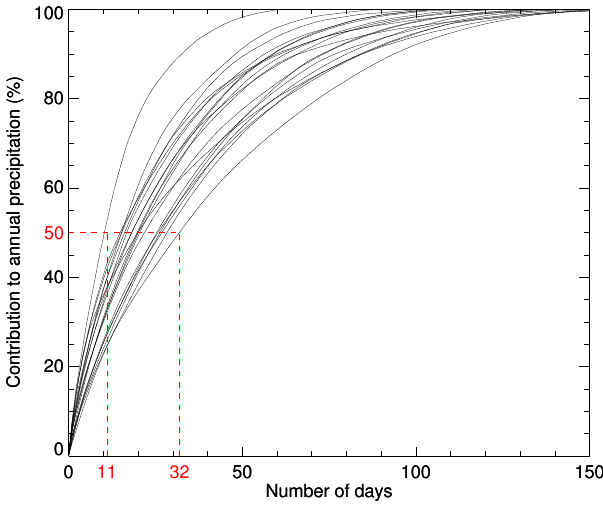
Fig. 2. Contribution (%) of accumulated daily precipitation to the annual precipitation in the year 2008 for the 19 available weather stations. The daily precipitation values are sorted in decreasing order. The number of days in which 50 % of the annual precipitation is reached are indicated for the two extremal stations.